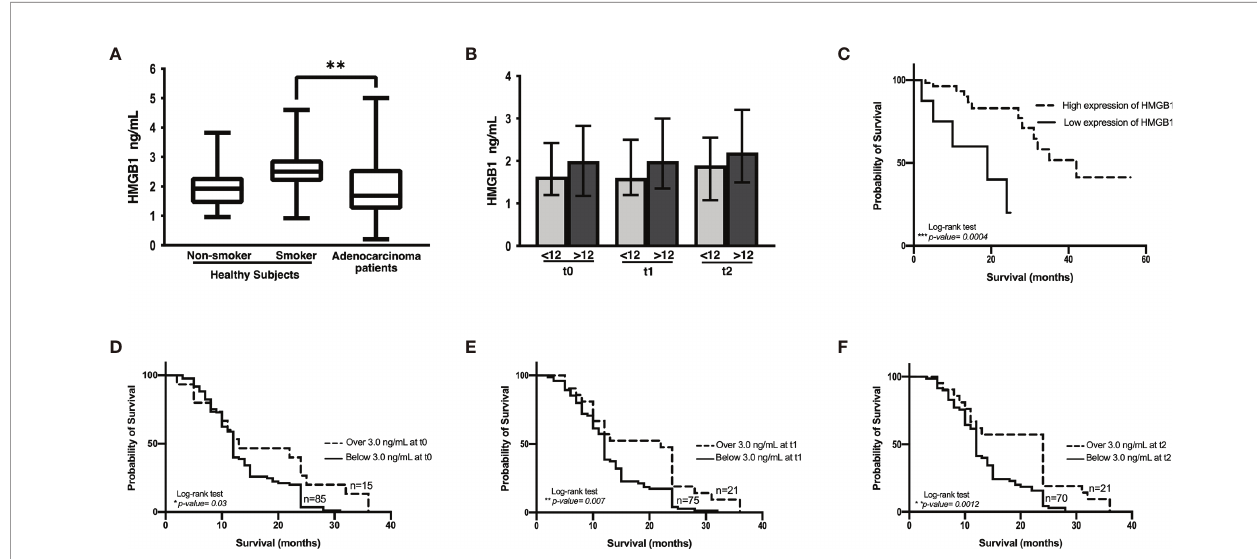
FIGURE 4 | HMGB1 plasma concentration. (A) Comparison among healthy non-smokers, smokers, and lung adenocarcinoma patients before the start of therapy. Statistical signi fi cance was found in the control smoker group and lung adenocarcinoma patients (** p = 0.0096). (B) HMGB1 concentration in the cohort of patients with lung adenocarcinoma classi fi ed with respect to shorter (<12 months) and longer (>12 months) overall survival and before the start of treatment (t0) and prior to the third (t1) and to the sixth (t2) chemotherapy cycle. (C) Kaplan – Meier analysis of patients from the Lung Adenocarcinoma project of The Cancer Genome Atlas